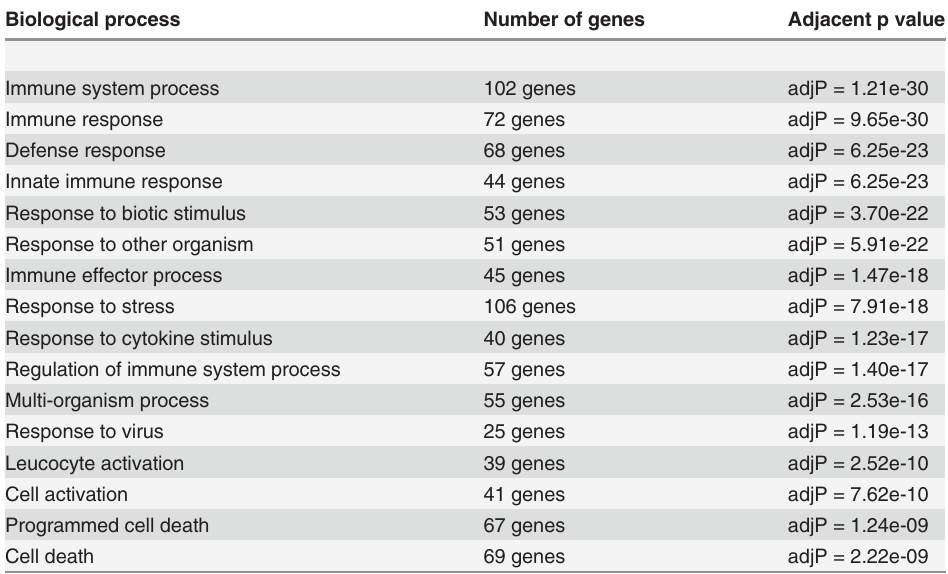
Table 2. We used Webgestalt to identify overrepresented GO terms in > 2 fold upregulated genes in the glioma-regulated (red and brown) modules. Biological